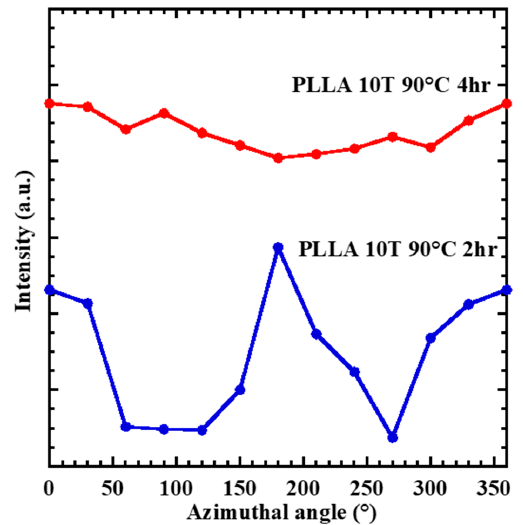
Figure 4. XRD (110)/(200) intensity along the azimuthal angle for PLLA10T2 and PLLA10T4 films.